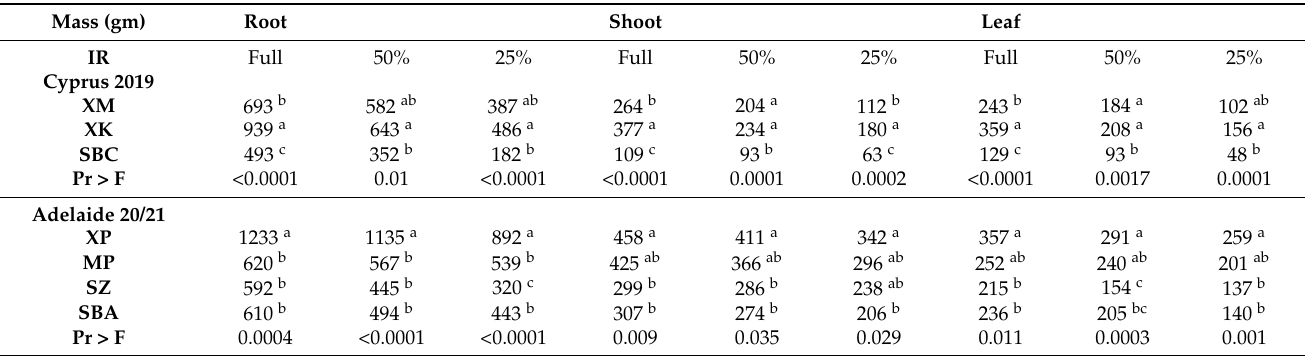
Table 6. Fresh root, shoot and leaf mass (EL 38 Harvest) measures for potted trials for seasons 2019 and 2020/2021.